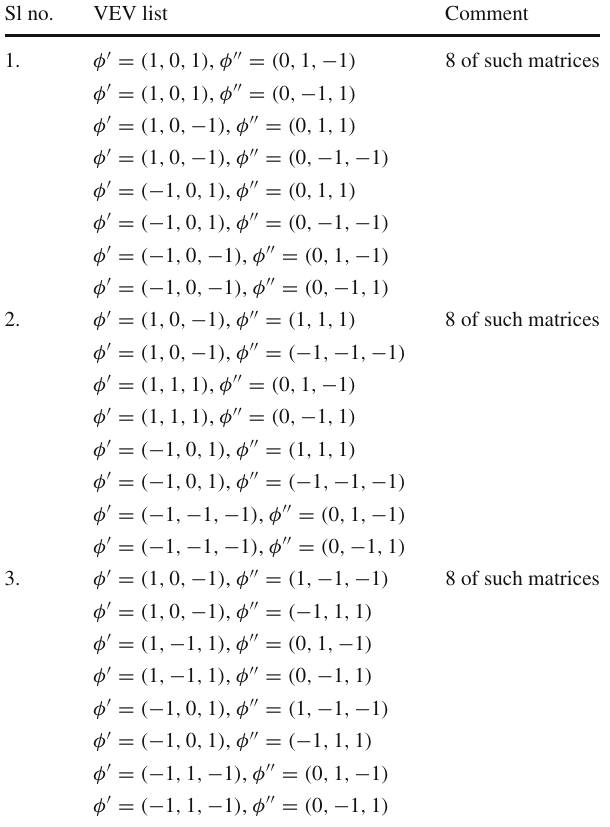
Table 19 VEV alignment of triplet flavon fields φ (cid:3) , φ (cid:3)(cid:3) for (μ − τ) symmetric case, that give rise to same complex constraints Sl no. VEV list